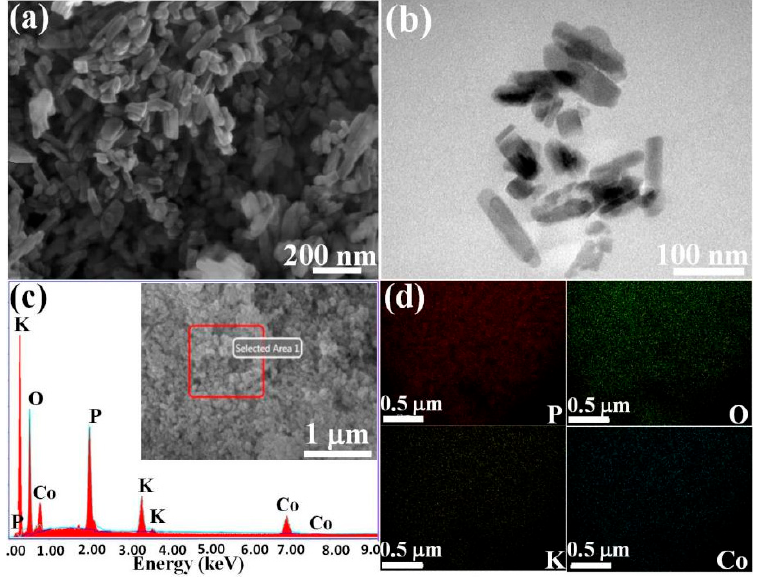
Figure 2. ( a ) SEM image of LCPP; ( b ) TEM image of LCPP; ( c ) EDS spectrum of LCPP, and the inset is the corresponding SEM image; ( d ) SEM elemental mapping images of LCPP nanocrystal whiskers from the area in the inset of ( c ).